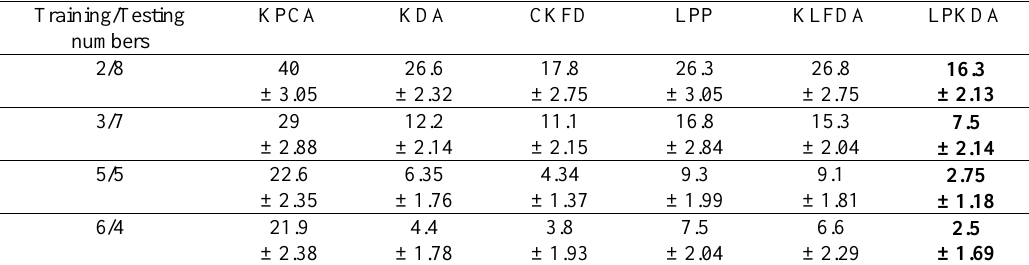
Table 4. The average error rates (%) across 10 tests and their standard deviations (std) on ORL database. Training/Testing